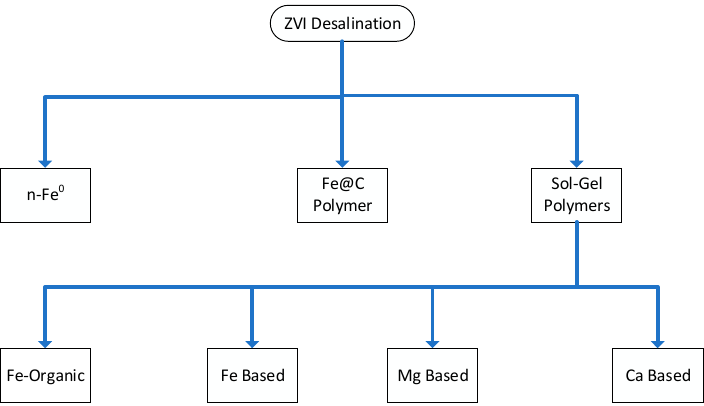
Figure 1. ZVI desalination approaches considered in this study.